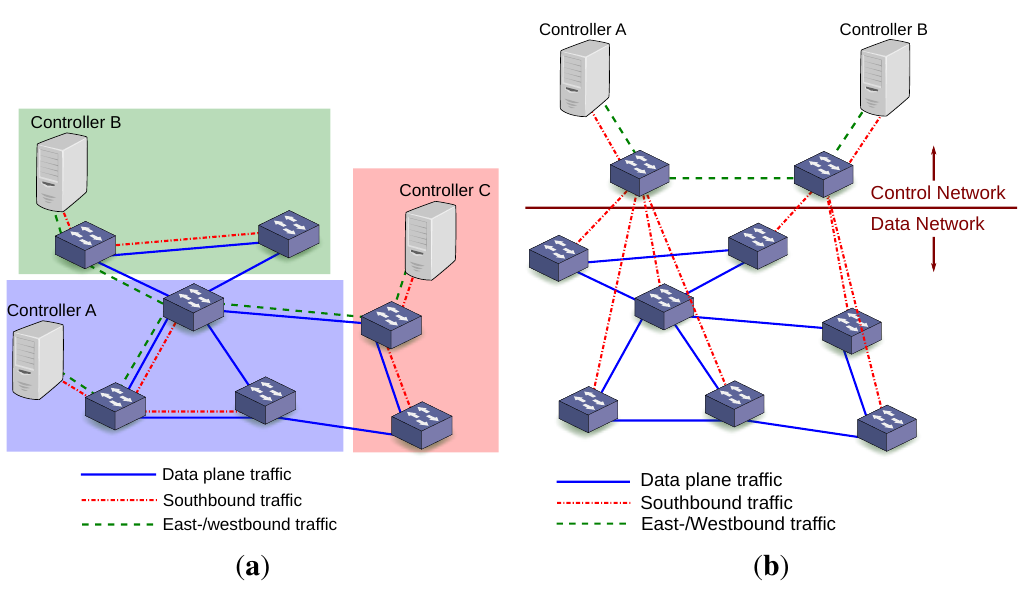
Figure 9. ( a ) In-band signaling; ( b ) Out-of-band